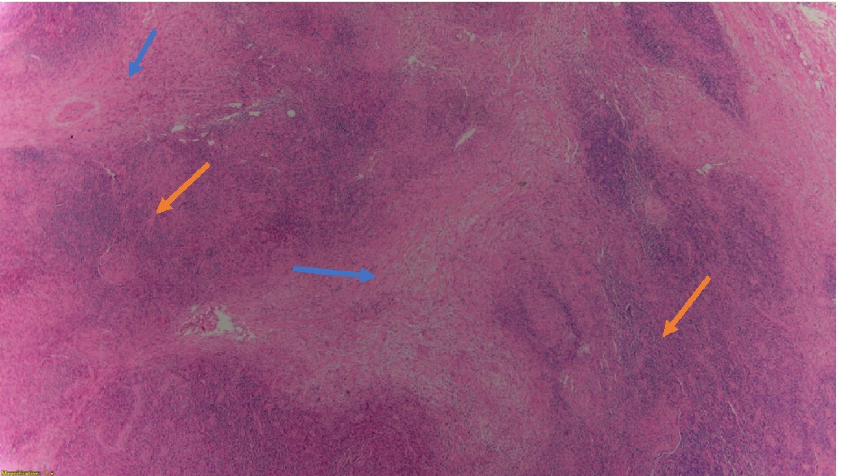
Figure 2. Hematoxylin and eosin magnified (4×) image of patient’s lymph node. Here, the tumor consists of nodules (yellow arrows) partly surrounded by collagen bands (blue arrows). The lymph node biopsy result also shows more than 80% of the nodules with fibrotic composition which is indicative of a grade II nodular sclerosing classical Hodgkin lymphoma (NS-CHL). Although these features do share similarities with anaplastic large cell lymphoma of the Hodgkin-like type (ALCL- HL), the later should only be considered only when the nodules consist exclusively of basophilic blasts. Thus, this differentiates our diagnosis from that of ALCL-HL.